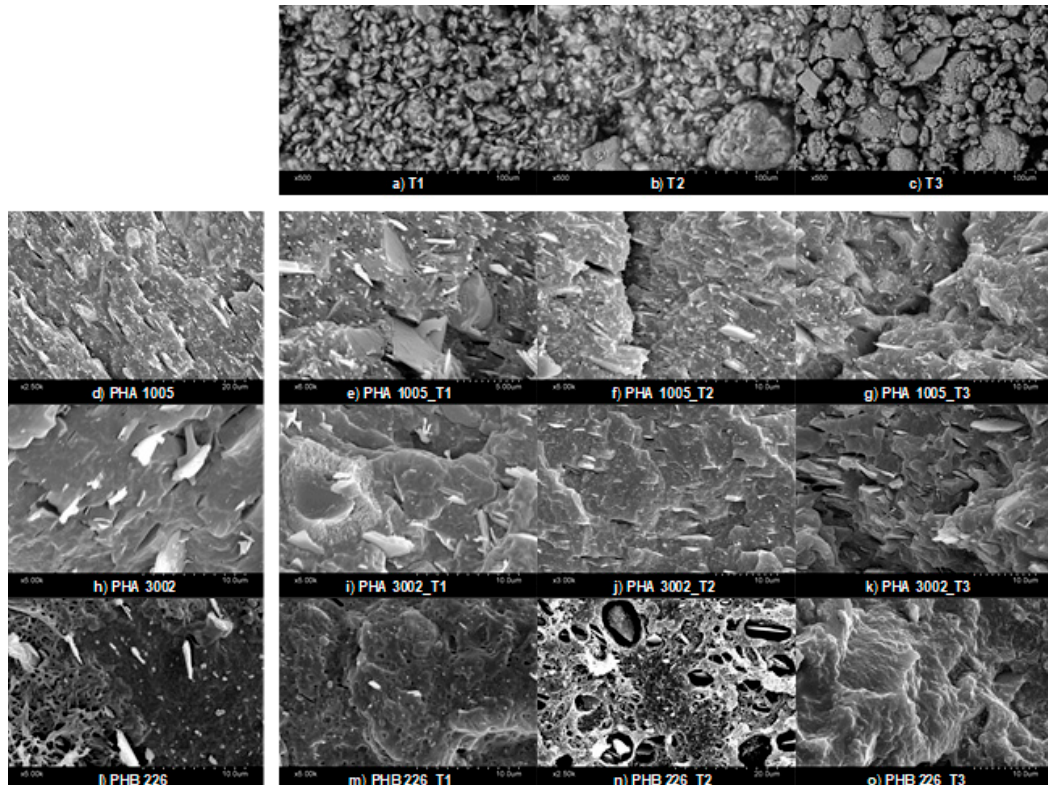
Figure 1. SEM micrographs of nanoclays ( a , b , c ); neat matrices ( d , k , l ) and composites: PHA1005 composites ( e , f , g ), PHA3002 composites ( i , j , k ); PHB226 composites ( m , n , o ).